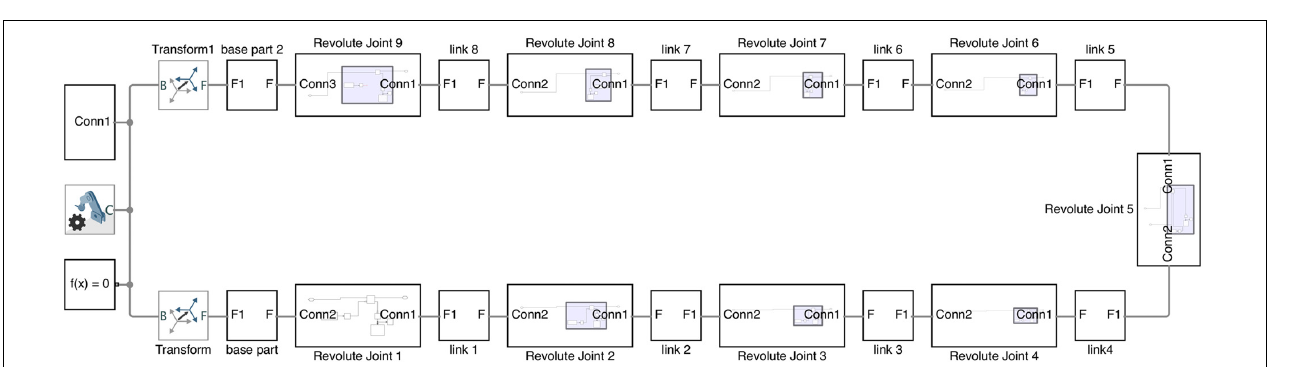
FIGURE 6 | Automated process of the reconfiguration sequence.